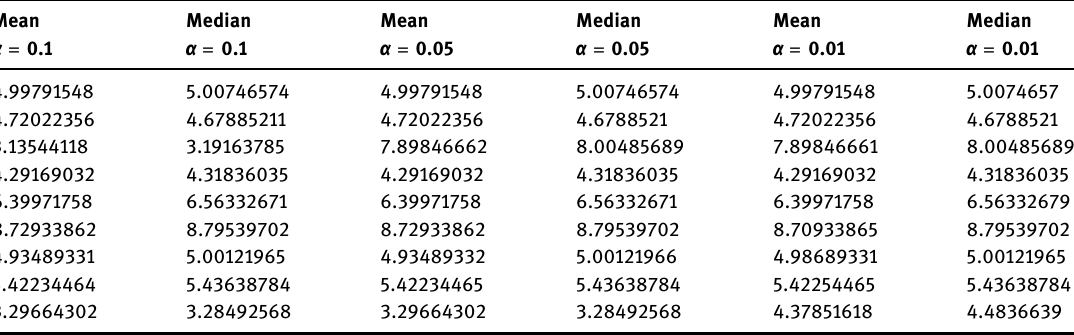
Table 2: Sample of ten replications of Grubbs ’ test out of 1,000 replications